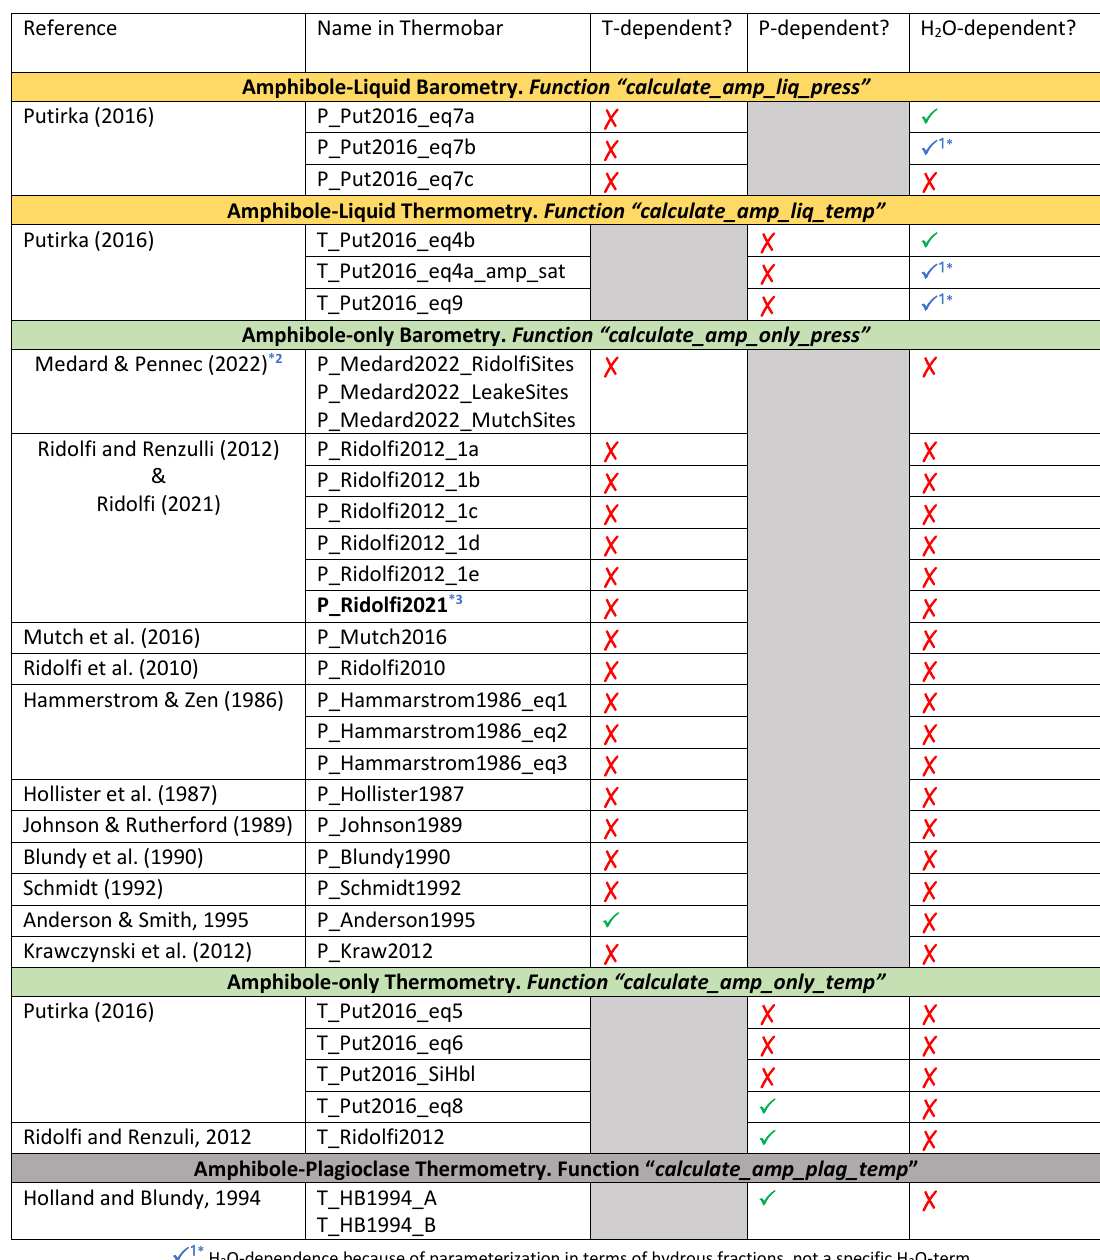
Table A6: Summary of equations for amphibole thermobarometry. From: Ridolfi 2021, Putirka 2016, Mutch et al. 2016, Krawczyn- ski et al. 2012, Ridolfi and Renzulli 2012, Hollister et al. 1987, Ridolfi et al. 2010, Hammarstrom and Zen 1986, Johnson 1988, Blundy and Holland 1990, Schmidt 1992, Anderson and Smith 1995, Holland and Blundy 1994, Médard and Le Pennec